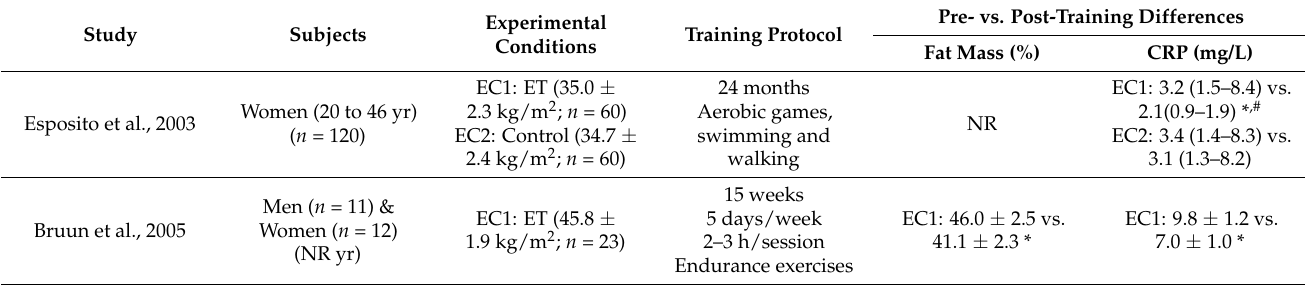
Table 1. Effects of training on the circulating concentrations levels of CRP in sedentary adults with overweight or obesity. Study